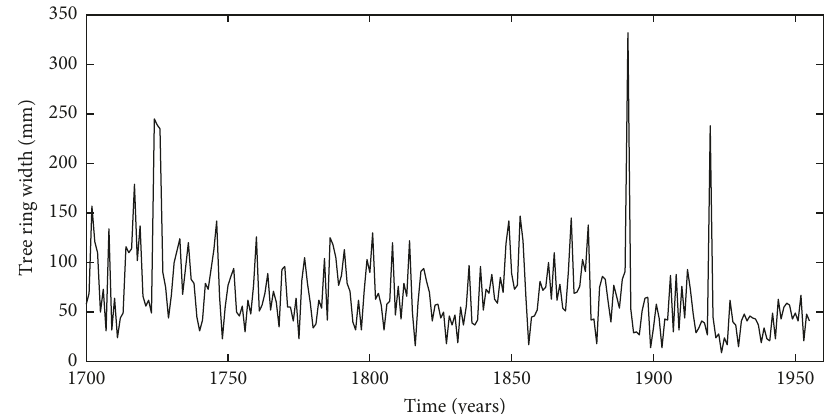
Figure 1: Tree ring width in the Huangdi Tomb.